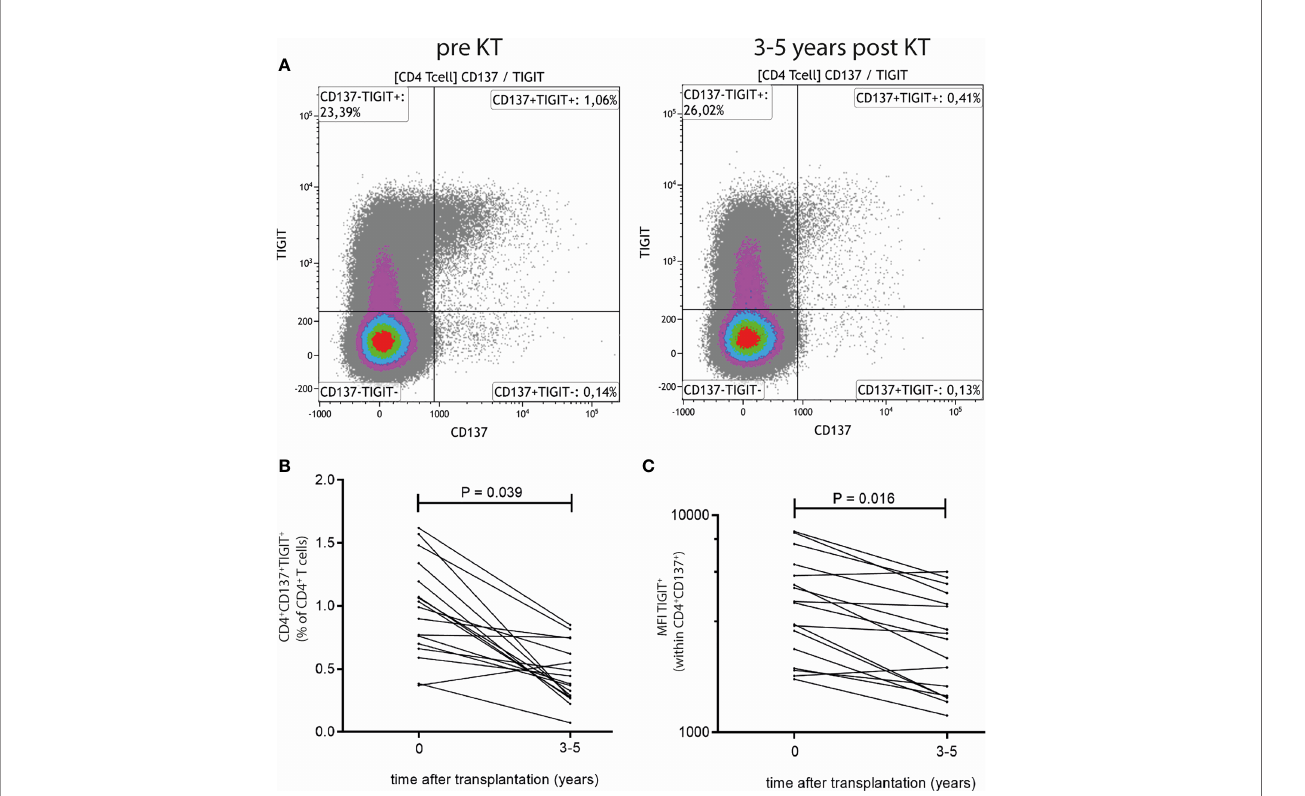
FIGURE 2 | Traditional 2D fl ow cytometric analysis con fi rms reduction in frequency and MFI of TIGIT expression within donor-reactive CD4+CD137+ T cells. (A) Typical fl ow cytometric example of TIGIT expression prior to (left plot) and 3-5 years after KT (right plot). Percentages in upper right quadrant indicate CD4+ T cells which express CD137 and TIGIT. (B) Percentages of CD4+CD137+TIGIT+ as a percentage of total CD4+ T cells and (C) MFI of TIGIT expression within CD4+CD137+ T cells prior to and 3-5 years post KT for 9 elderly and 8 young KT recipients are depicted. The Wilcoxon signed rank test was used to compare samples prior to KT to those 3-5 years after KT and a P-value < 0.05 was considered statistically signi fi